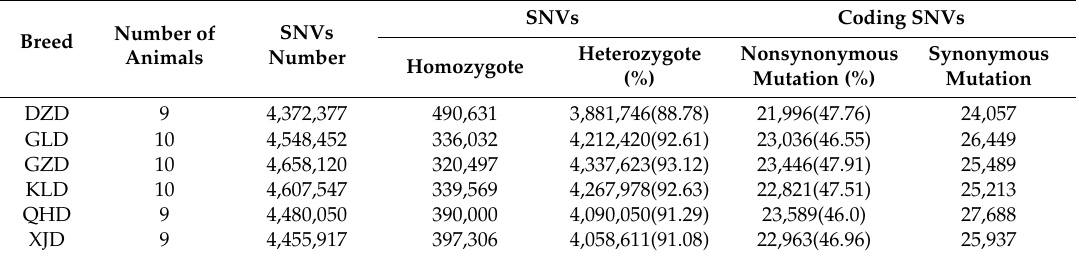
Table 2. Summary and annotation of single nucleotide variants (SNVs) and indels in the donkey genome.